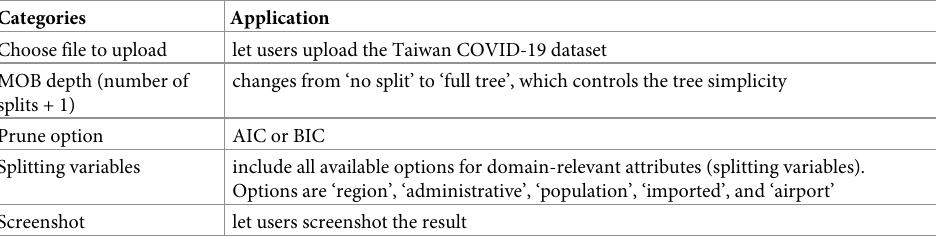
Table 2. Taiwan COVID-19 interactive tool